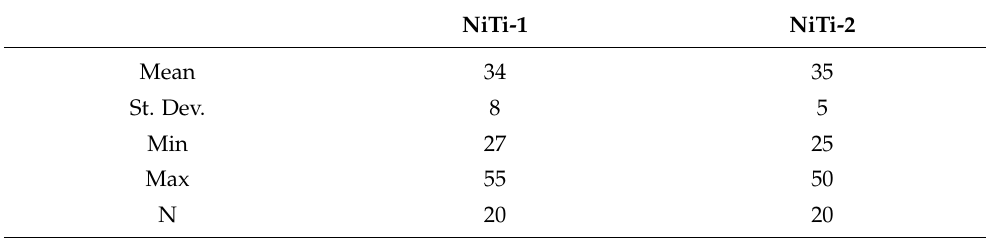
Table 5. The descriptive statistics of the oxide layer thickness (in nm) for NiTi-1 and NiTi-2 samples. NiTi-1 NiTi-2 Mean